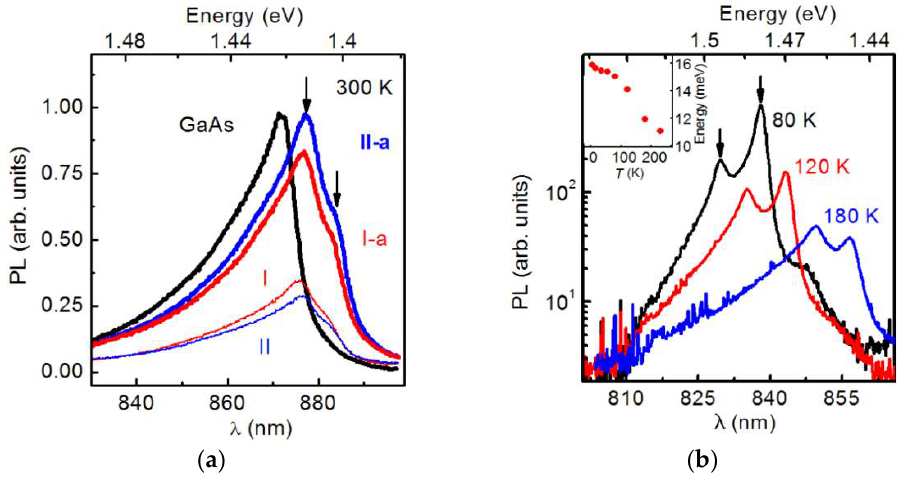
Figure 5. ( a ) Steady-state PL spectra of the GaAs/Si HS and the GaAs/GaAs test structure measured at 300 K. The spectra of various HSs are marked with the corresponding symbols (see Table 1). The arrows indicate the peak positions of the PL bands for GaAs/Si. ( b ) The PL spectra of the GaAs/Si II-a HS measured at different temperatures. The energy difference the between two PL peaks is shown in the inset as a function of temperature.